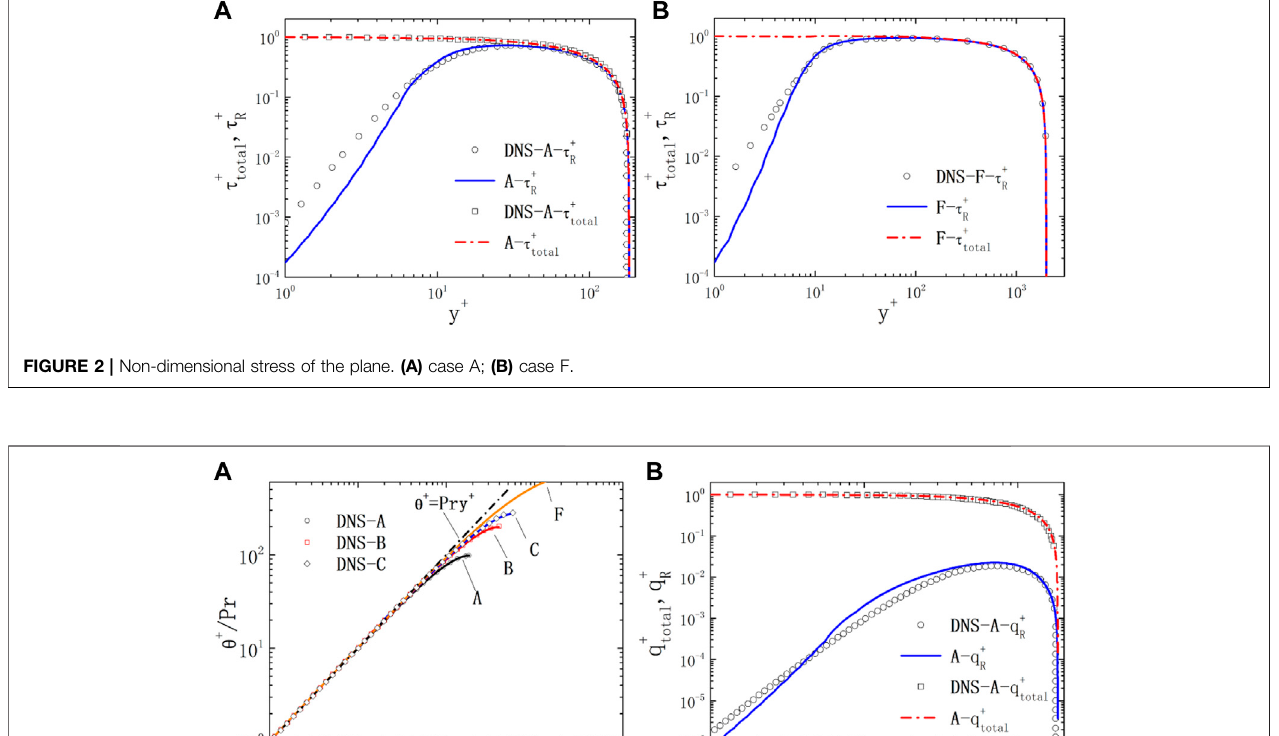
Frontiers in Energy Research |